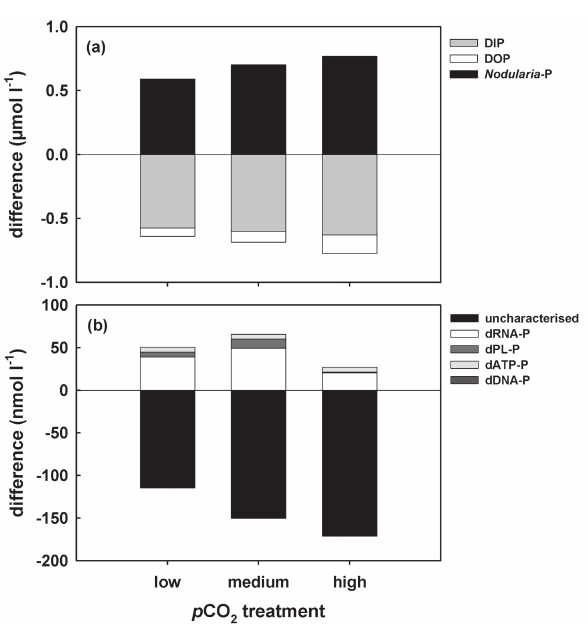
Fig. 3. Changes of the P pool (a) and the DOP pool (b) between day 9 and day 0 of the 15-day incubation experiment for the three different p CO 2 treatments